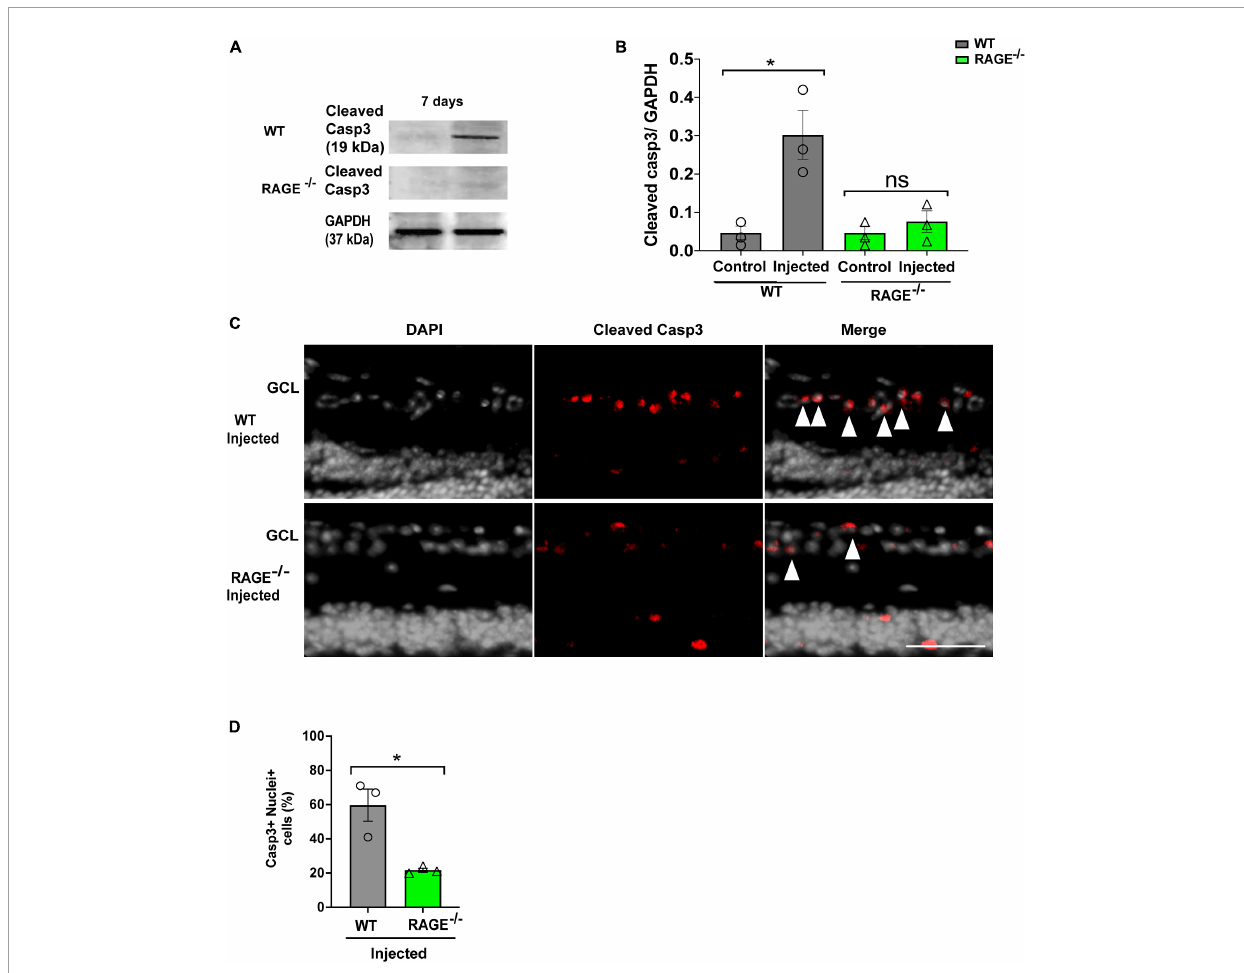
FIGURE6 Assessment of apoptotic cell death in the A β injected group. (A,B) Western blotting of cleaved caspase 3 (19kDa) in control and injected retinas of WT and RAGE − / − mice. GAPDH was used as a control, followed by quantification of cleaved casp3 in animal groups using densitometry ( n = 3). (C) Immunostaining shows a increased labeling of cleaved casp3 (red) and the nuclei (gray) in the GCL of injected WT and RAGE − / − groups ( n = 3). (D) Quantification represents a significant increase in the density of casp3 + nuclei + cells in WT injected group, compared to RAGE − / − mice. * p = 0.02, ns: no significance unpaired t -test. The scale bar is 100 µ